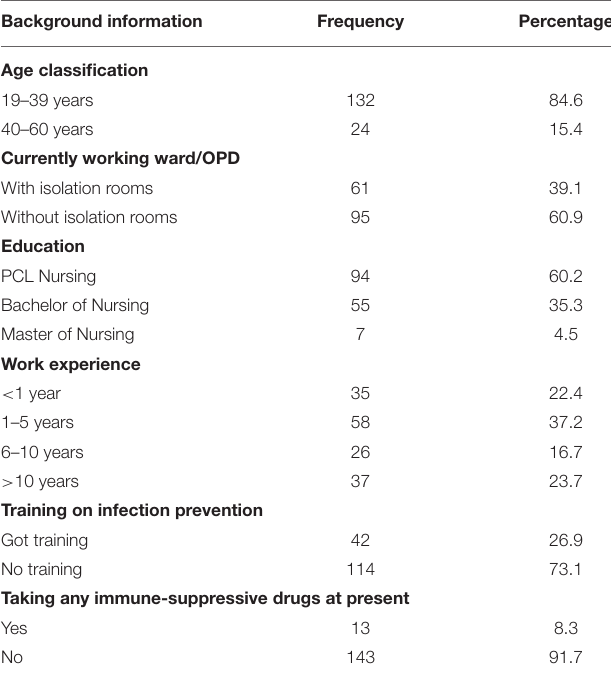
TABLE 1 | Background characteristics of respondents n =